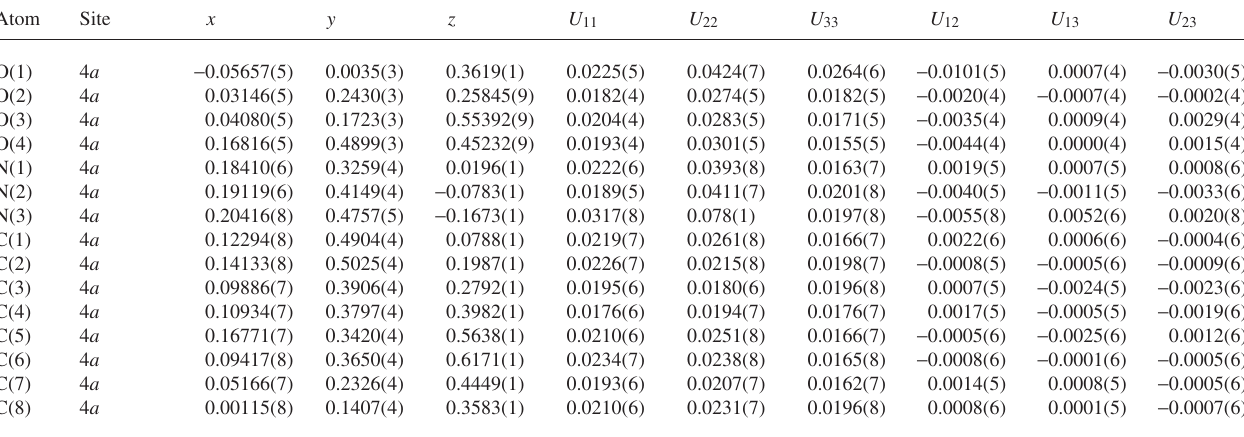
Table 3. Atomic coordinates and displacement parameters (in Å 2 )